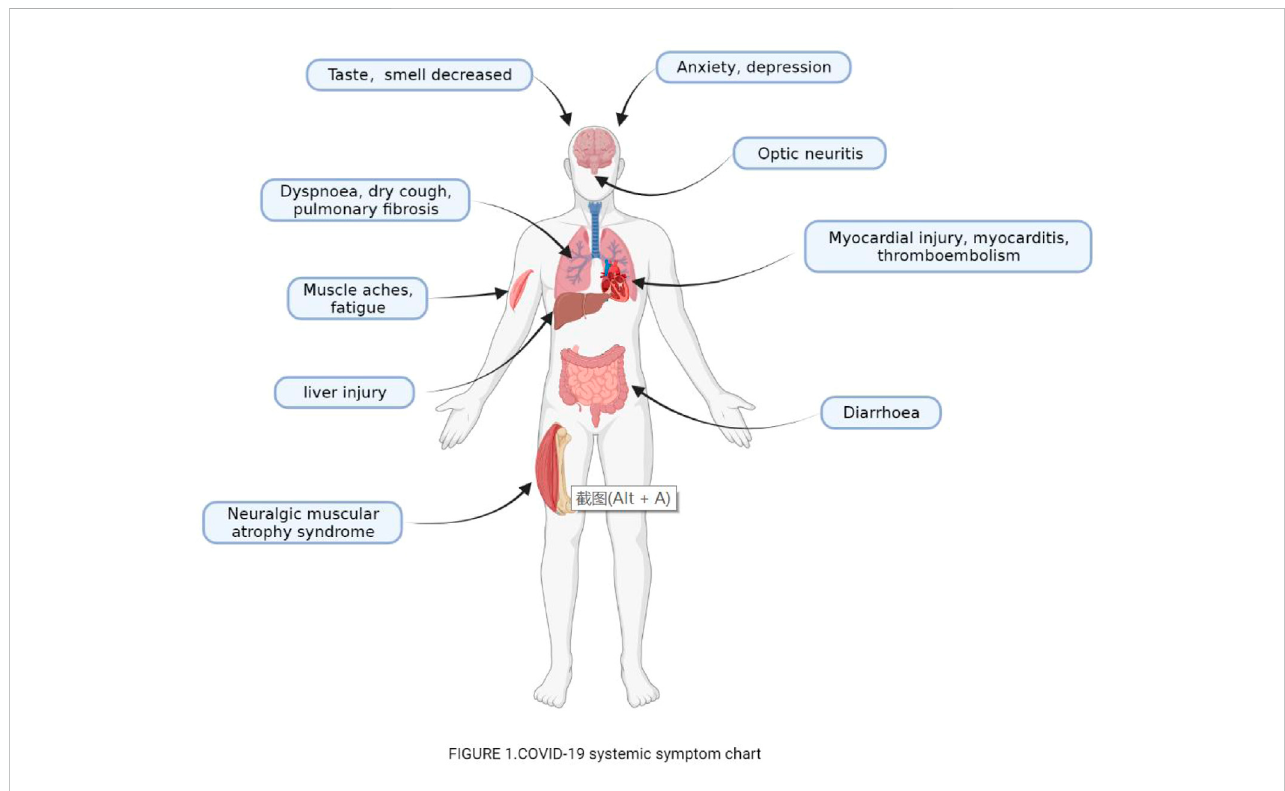
FIGURE 1 COVID-19 systemic symptom